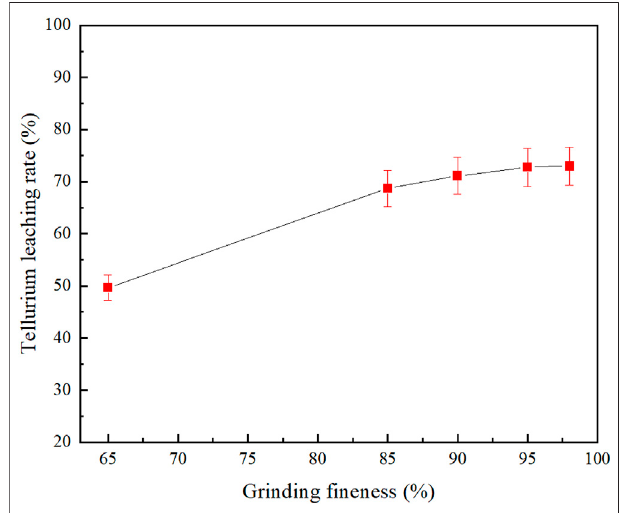
FIGURE 3 | Effect of grinding fi neness on tellurium